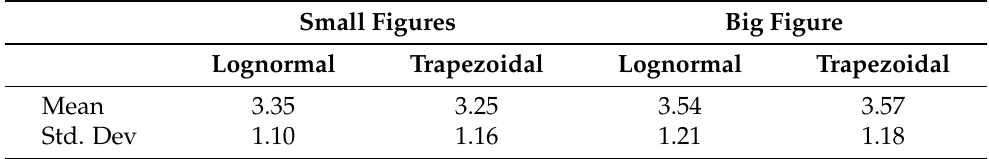
Table 2. Movement evaluation (1 unfriendly–5 very